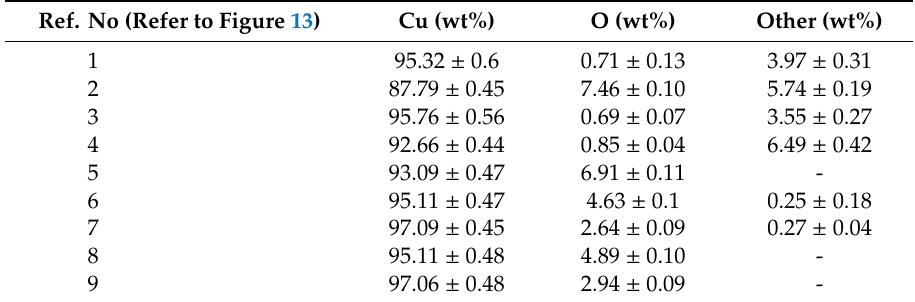
Figure 13. SEM images of two Cu-coatings prepared for EDX-analysis. Left: ( a ) λ = 0.57; total gas volume = 190 slpm; Right: ( b ) λ = 1; total gas volume = 230 slpm. Taken from [21]. Table 4. EDX-Cu and O wt% values achieved from EDX on the samples shown in Figure